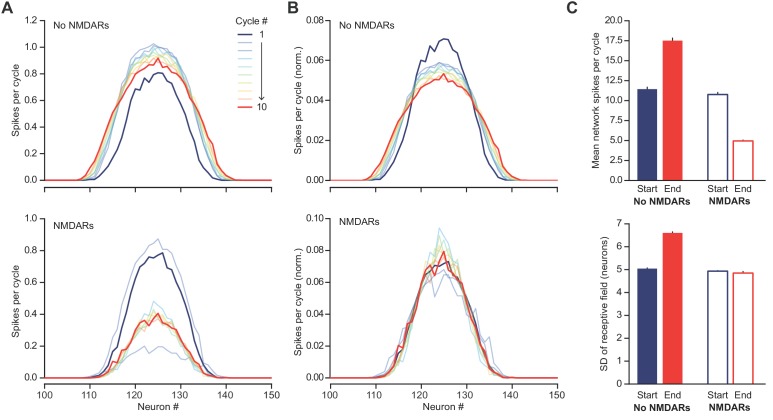
NMDARs help to maintain a sparse and sharp representation of a ‘hump’ of excitation to the feedback circuit shown in Figure 5D.(A) Distribution of firing rate by neuron during each PV+ interneuron firing cycle, averaged across 500 simulations. Top – without NMDARs, bottom – with NMDARs. The hump of excitation was centered on neuron #125. Note the similarity of the first cycle between the two conditions. The behaviors of the networks diverge as the NMDARs are engaged. (B) As (A) but normalized by total firing rates across neurons, for better comparison of distribution dispersion. (C) Comparison of first and tenth simulation cycle: top – mean spikes per cycle, bottom - standard deviation of average network ‘receptive field’.